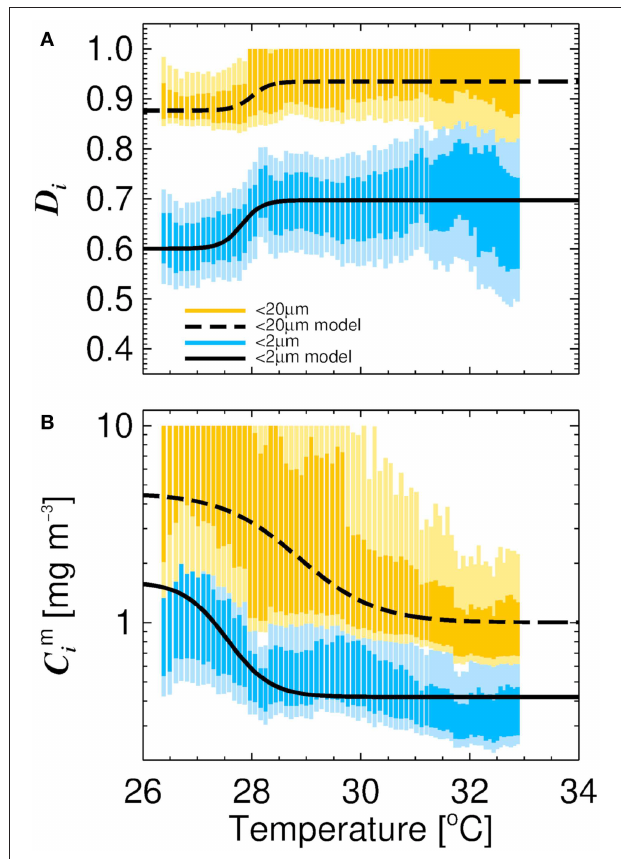
FIGURE 3 | Relationship between the parameters of the three-component model and water temperature derived from sorting the dataset and conducted a running fit of the model (bin size 60 measurements) with increasing temperature. Average water temperature of each bin is on the abscissa and 13.6 and 86.4% (darker shading) and 2.5% and 97.5% (lighter shading) confidence intervals of the parameters from a bootstrap fit (1,000 iterations) on the ordinate (confidence intervals are constrained to realistic values, 0 to 10 for C m p , n and C m p and <1 for D p , n and D p ). (A) Shows the relationship between temperature and the parameters D p , n and D p . Solid black line is the model of Brewin et al. (2017b) tuned to the data (Equation 8) for cells <2 µ m and dashed line for cells <20 µ m (Equation 7). (B) Shows the relationship between temperature and the parameters C m p , n and C m p . Solid black line is the model of Brewin et al. (2017b) tuned to the data (Equation 6) for cells <2 µ m and dashed line (Equation 5) for cells <20 µ